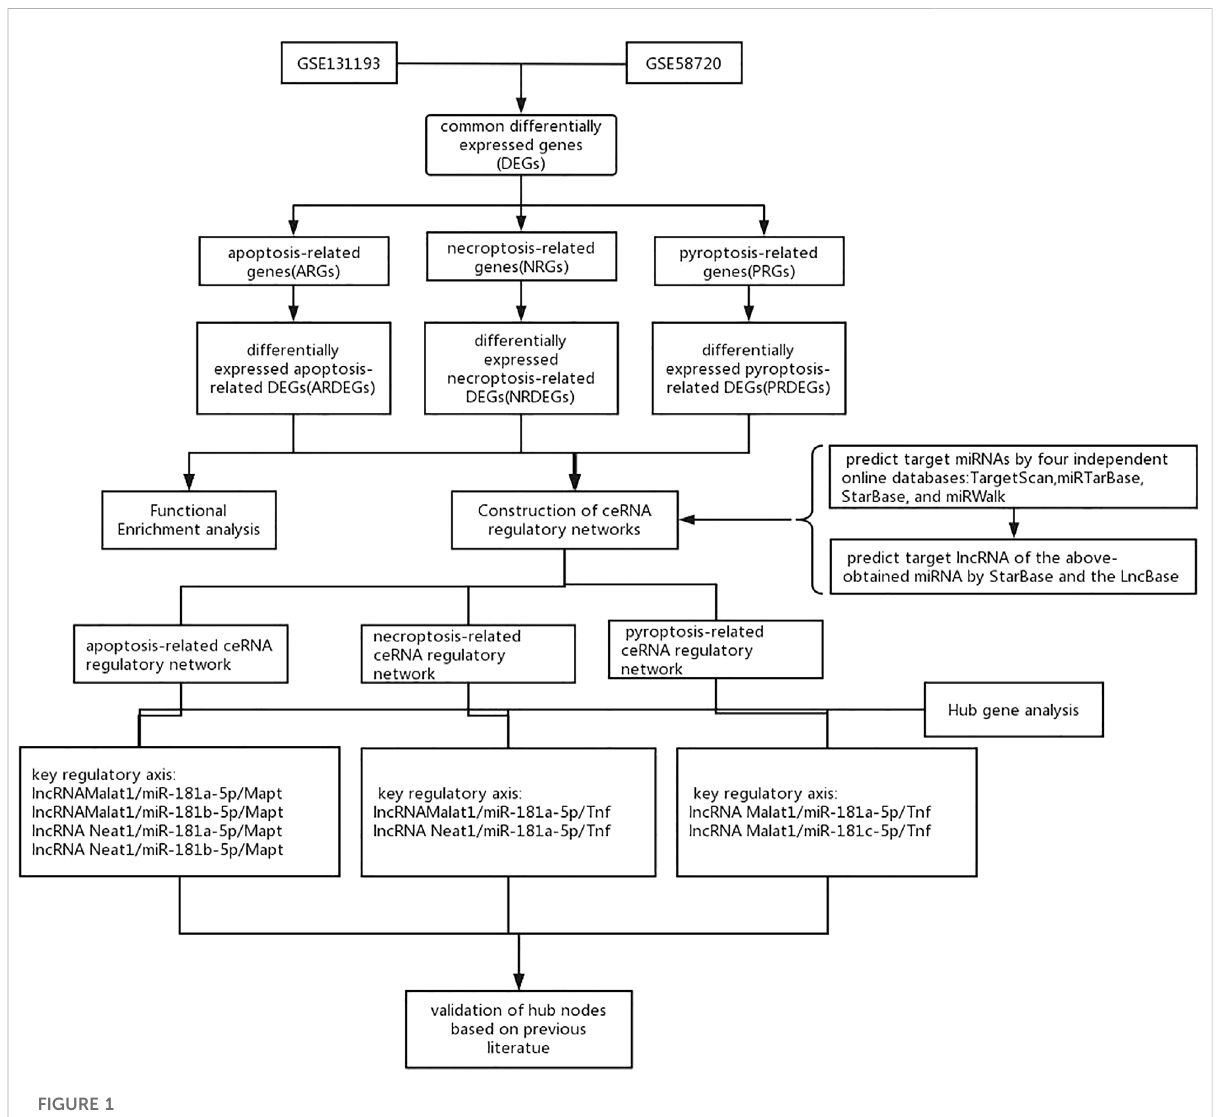
FIGURE 1 Flowchart of the analytical steps of this